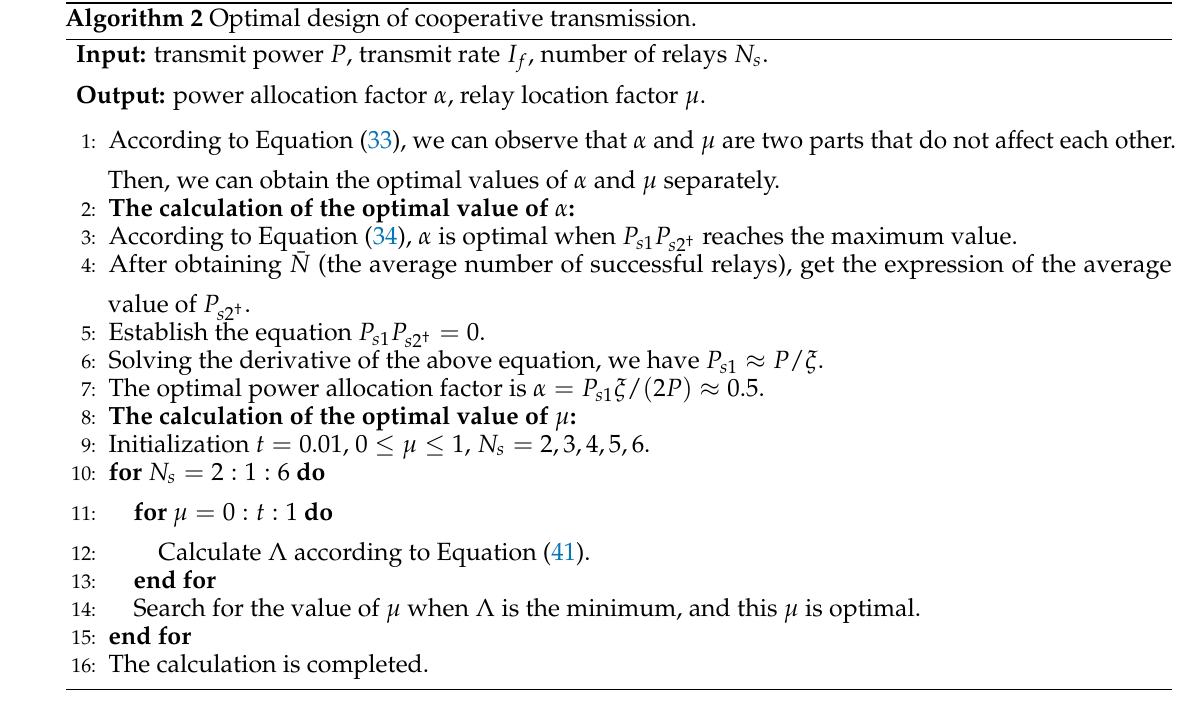
Algorithm 2 Optimal design of cooperative